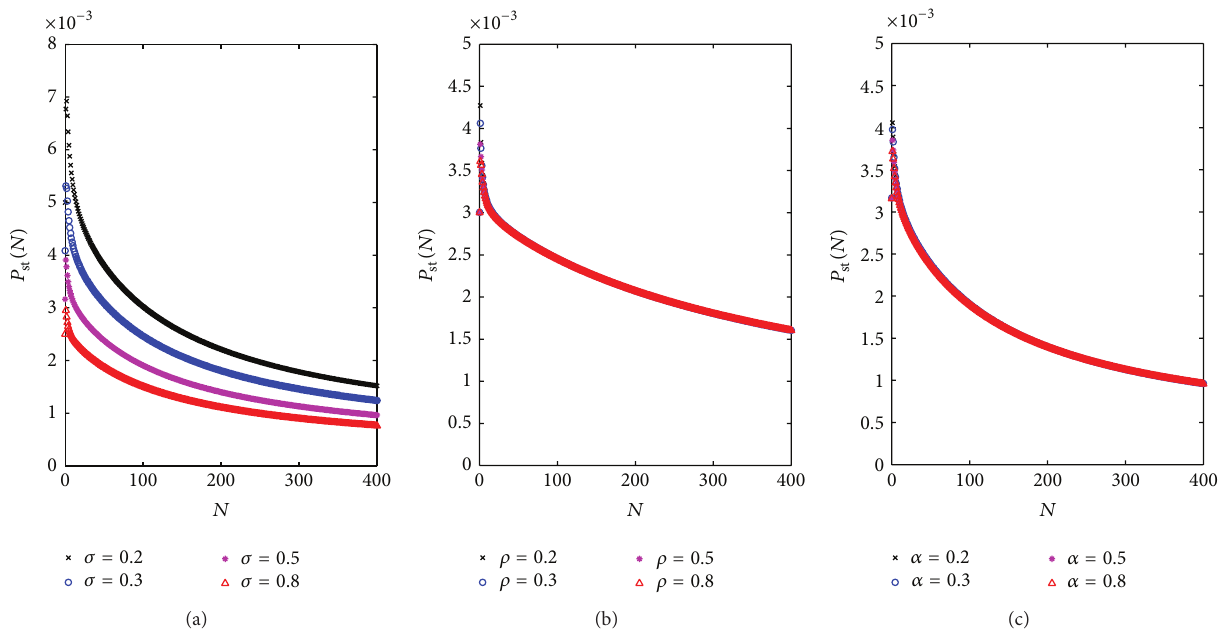
(𝑁) is plotted as a function of 𝑁 when 𝜎 , 𝜌 , and 𝛼 are st